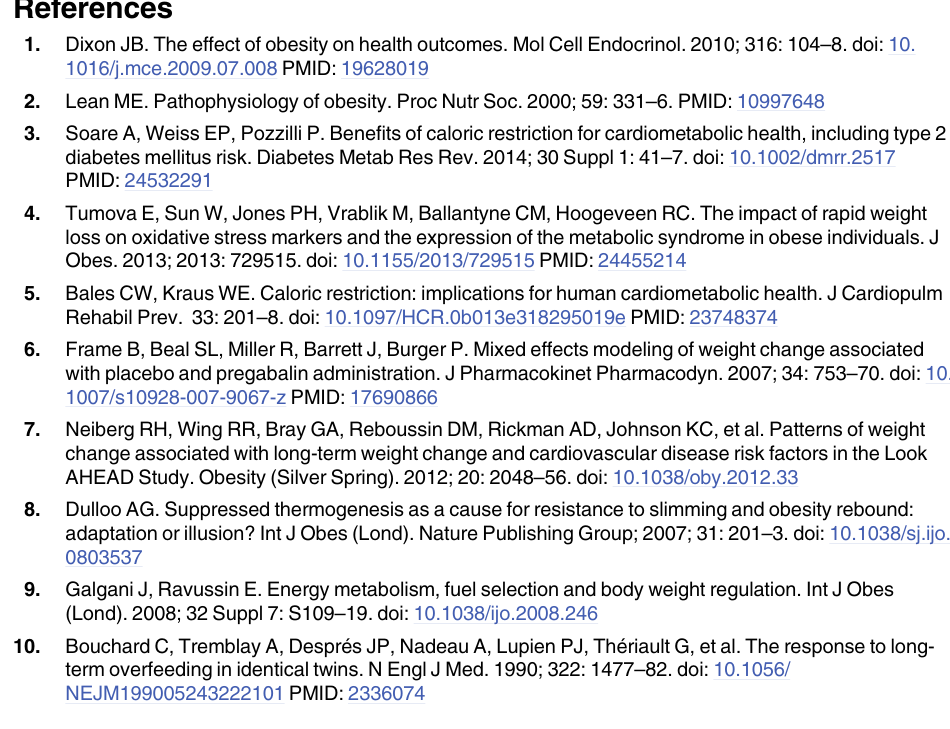
S1 Fig. CPS1 glycine network KEGG pathways gene enrichment. Gene enrichment per- formed with David for KEGG pathways. The dendrogram represents the distance within GO terms relatively to the number shared genes. The number of genes in each term is represented in the bar chart while the color of the bars represents the % of pathway coverage (i.e. the ratio of genes in the term in the network over the total number of genes in the term). The p-value for each term ’ s enrichment is reported in the plot (adjusted p-value (FDR) < 0.05). (TIF) S2 Fig. CPS1 gene expression and weight maintenance before (A) and after (B) outliers removal. Box plots for CPS1 gene expression at PWL, for weight maintainers (WMs) and weight maintenance resistors (WRs), defined as Δ BMI < 4% and Δ BMI > = 4% increase. A) WMs = 137, WRs = 55, p-value = 0.23. B) WMs = 132, WRs = 53, p-value = 0.04. Both regres- sions were corrected for age and sex.